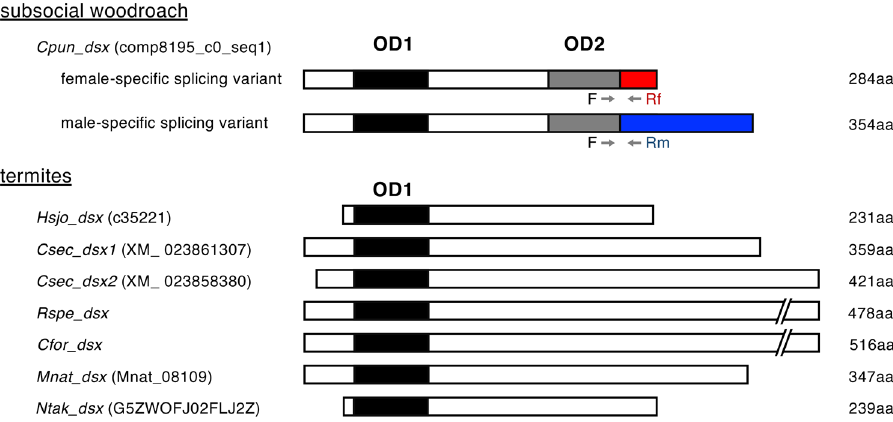
Figure 1. Domain organisations of dsx transcripts in a subsocial woodroach and in termites. Full-length coding sequence of dsx transcripts in one woodroach and six termite species are shown as transcribed from left to right. The OD1 is shown as a filled box, whereas the sexually shared, female-specific, and male-specific OD2 is shown as a grey, red, and blue box, respectively. Numbers on the right of boxes are amino acid lengths of the translated reverse primer for the male-specific variant, respectively (Table